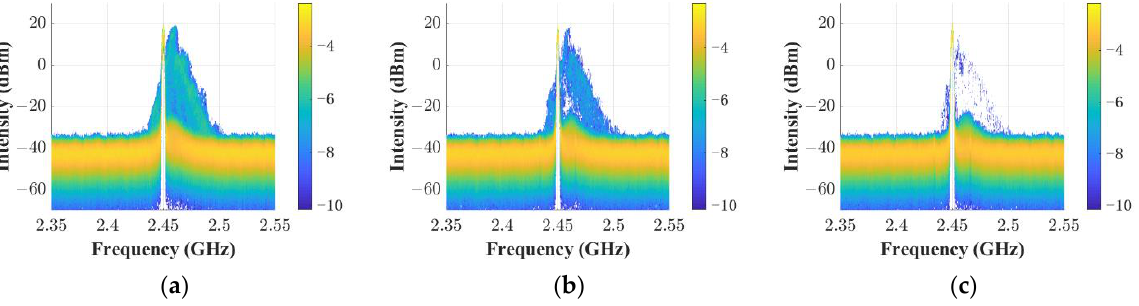
Figure 6. Measured DPX spectra of the magnetron with injecting amplitude at ( a ) 0.001, ( b ) 0.002 and ( c ) 0.003 under the power supply ripple S = 2.5%.